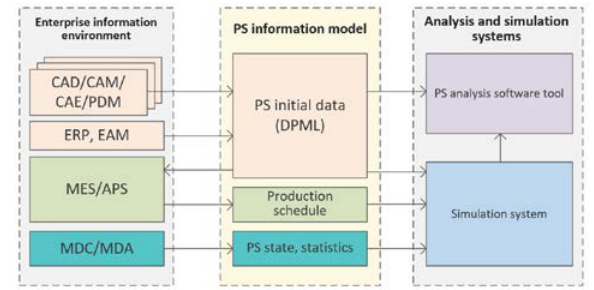
Fig. 2. Architecture for building a digital twin of a PS instance